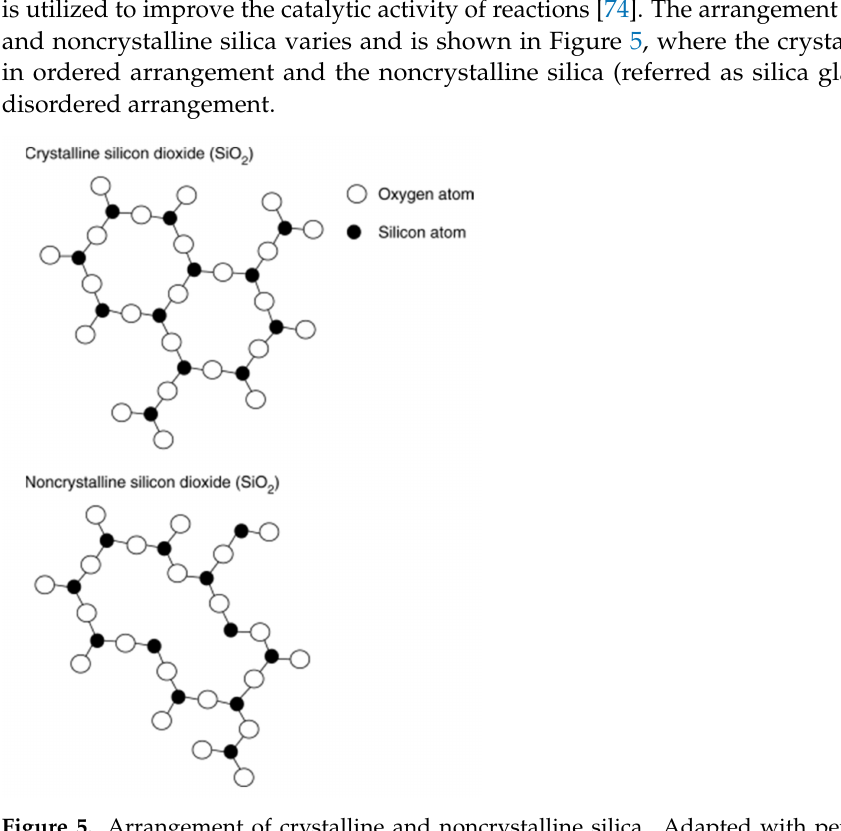
Figure 5. Arrangement of crystalline and noncrystalline silica. Adapted with permission from ref. [75]. 2004